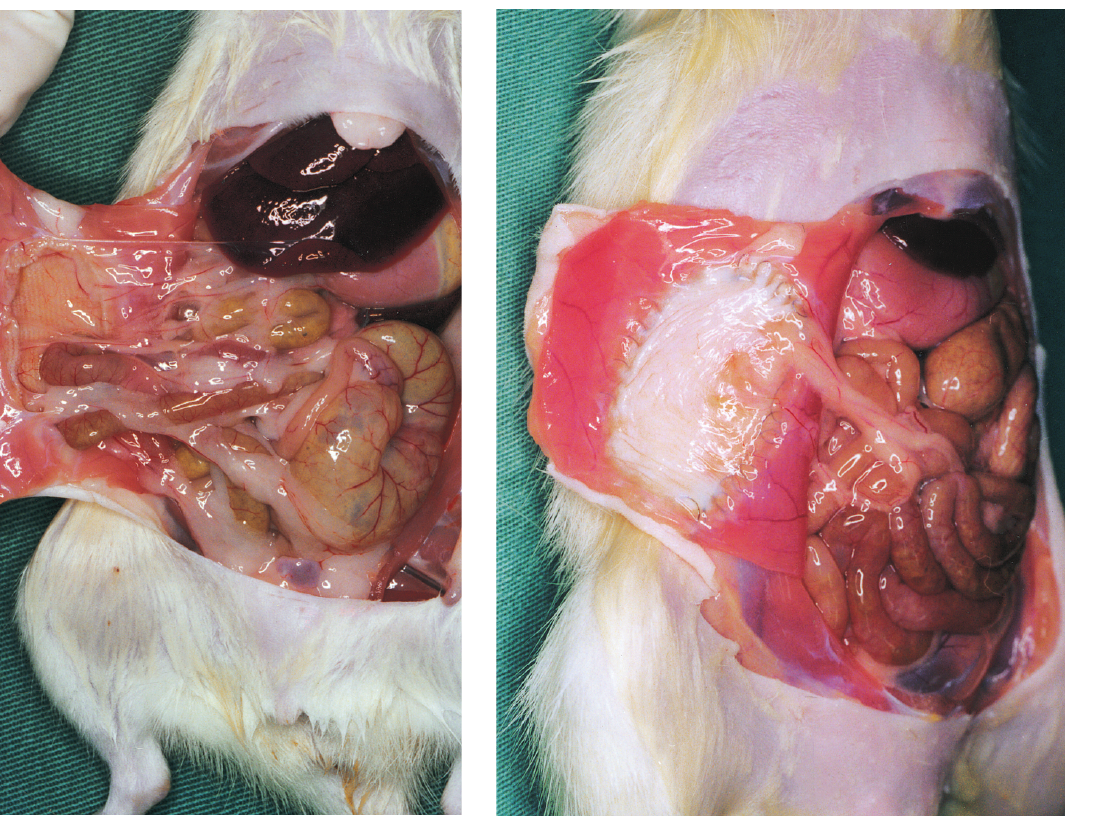
FIGURA 1 – Animal do grupo I aos 90 dias de pós-operatório. Observam-se firmes aderências das vísceras ao implante.